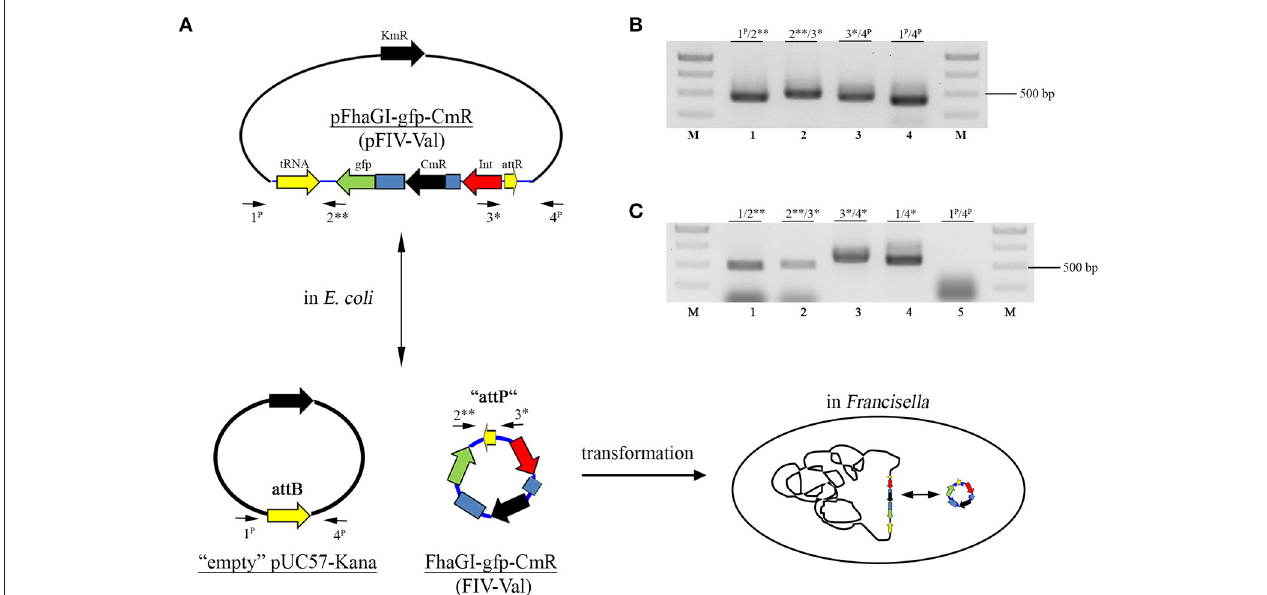
FIGURE 2 | Forms of pFhaGI-1-gfp-CmR. (A) In E. coli transformants three forms of the vector are present: the complete construct (pFhaGI-gfp-CmR, representing pFIV-Val), the “empty” pUC57-Kana vector with attB -site, and the episomal form with attP -site (FhaGI-gfp-CmR, representing FIV-Val). After transformation into Francisella the FIV-Val part integrates site specifically into the genome. Arrows indicate primers used to detect the different forms of pFhaGI-1-gfp-CmR. (B) PCR analysis of an E. coli transformant containing pFhaGI-1-gfp-CmR. (C) PCR analysis of Ft. holarctica LVS transformant containing FhaGI-1-gfp-CmR. Primers Fha-2/3 (Fha-2**/Fha-3*) show the presence of the episomal form, primers 1/2 and 3/4 (Fha-1/Fha-2** and Fha-3*/Fha-4* or Fha-1 P /Fha-2** and Fha-3*/Fha-4 P ) show the chromosomally integrated form of FhaGI-gfp-CmR, whereas primers 1/4 (Fha-1/Fha-4* or Fha-1 P /Fha-4 P ) show the chromosomal attB- site.